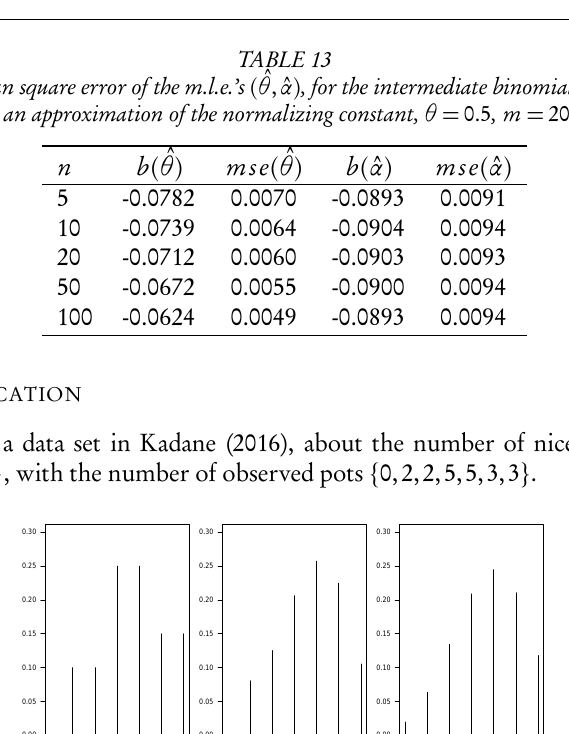
( ˆ θ , ˆ α ) } , in panel i